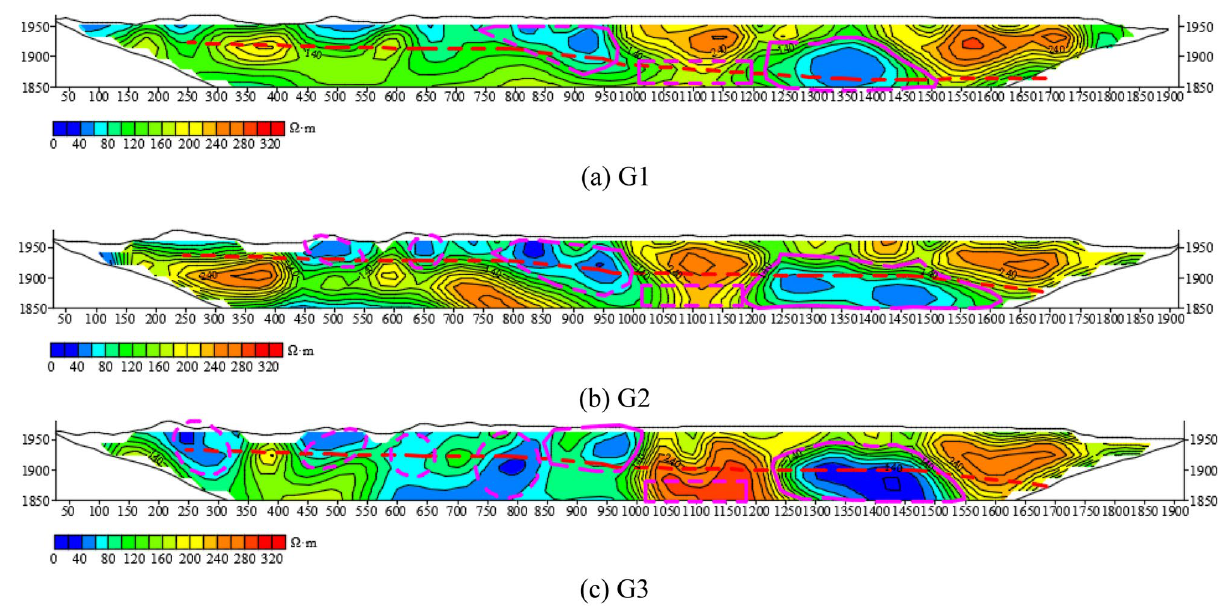
Figure 19. The resistivity profile of the HDRM of ( a ) G1, ( b ) G2, ( c ) G3.